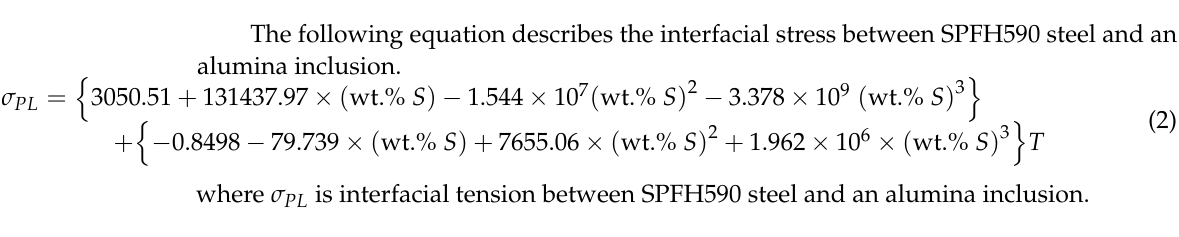
Figure 1. Representation of AC flash butt welding process. ( a ) arcing and melting; ( b ) pushed; ( c ) final